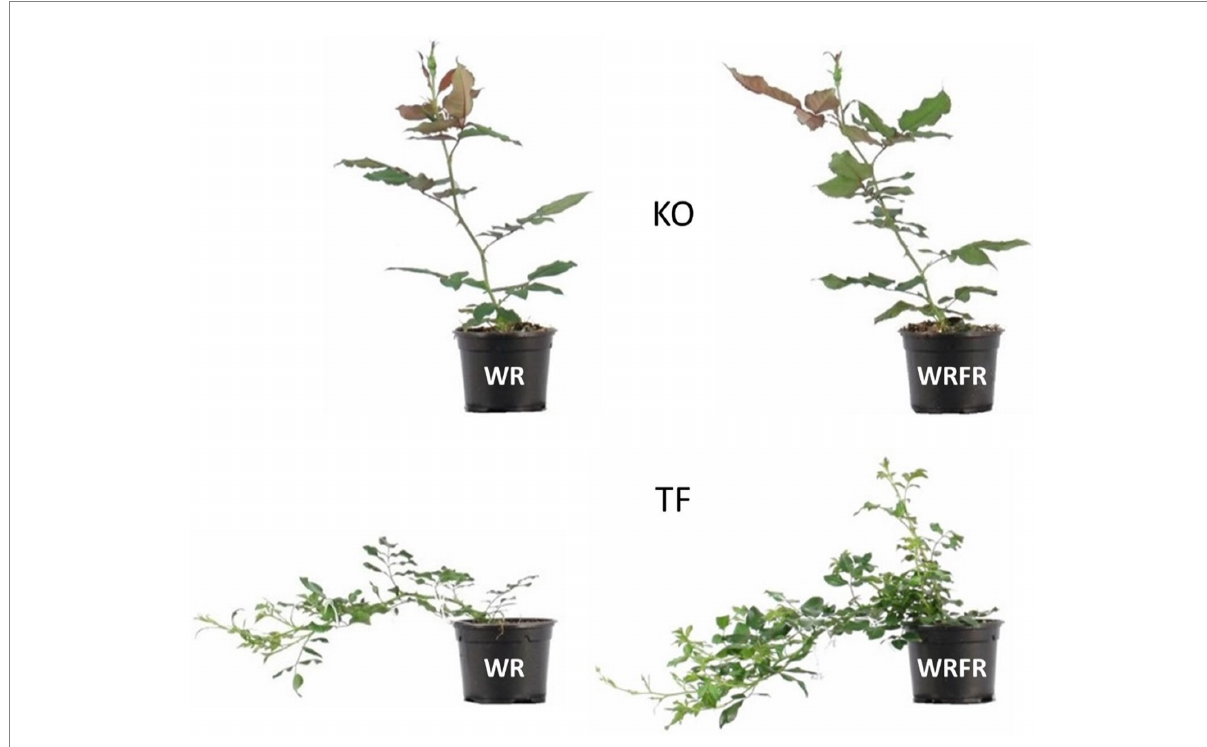
FIGURE 2 Overall shape of ‘The Fairy’ (TF) and Knock Out ® Radrazz (KO) grown in a climatic chamber under two light conditions—WR and WRFR—up to the ‘VFB of the order 2 axes carried by the order 1 long axis in apical position’